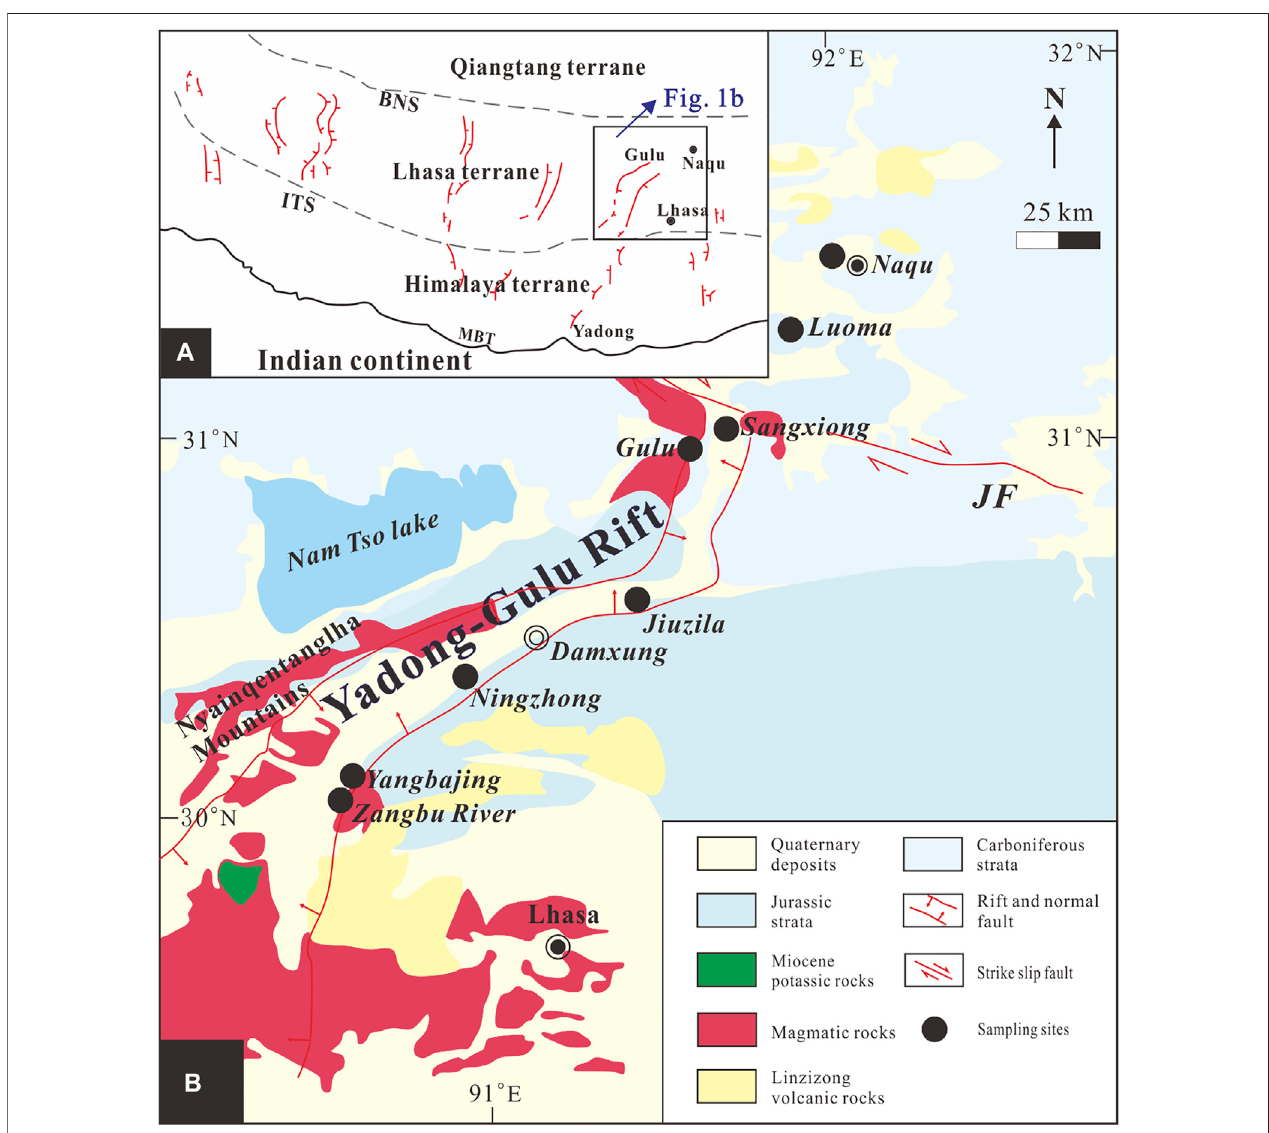
FIGURE 1 | (A) Simpli fi ed tectonic map of the Tibetan Plateau (modi fi ed from Yin and Harrison (2000)); (B) geological map of the northern Yadong-Gulu rift (modi fi ed from Zhang et al. (2017)) and hot spring gas sampling sites (the black dots in (B) ).